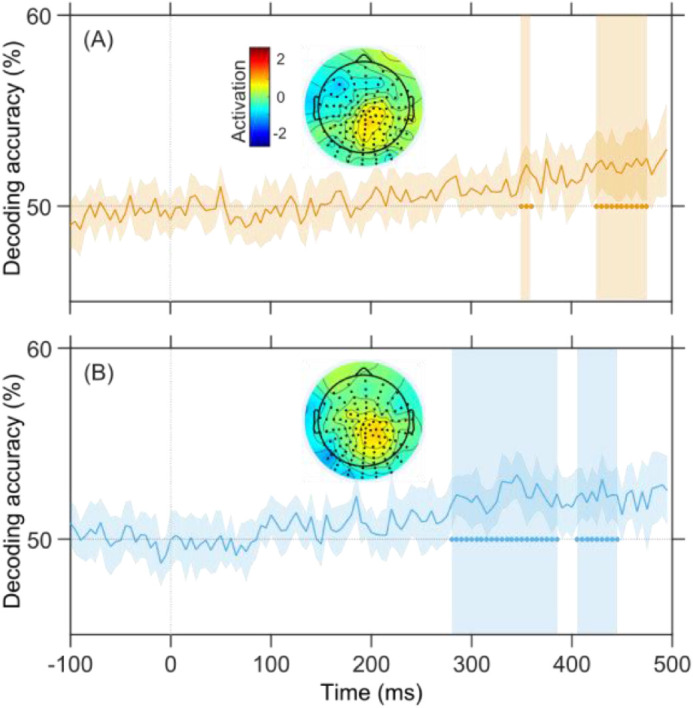
EEG decoding results. Top and bottom panels show results from the Contour and Surface fixed condition, respectively. Temporal evolution of the classification accuracy of the LDA along with a 95% confidence interval (CI) envelope. Cluster-based permutation identified significant temporal bins late in the trial evolution. The topographical maps portray the reconstructed signal activation based on estimated LDA weights, averaged across the vertical shaded areas.